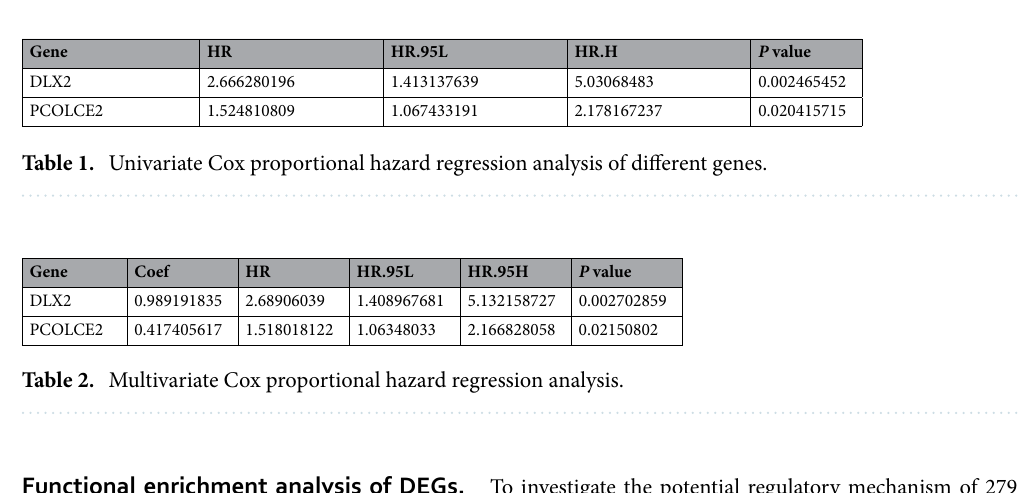
Figure 2. Functional enrichment analysis of DEGs. ( A ) The top 10 GO terms. ( B ) The top 10 KEGG pathways.